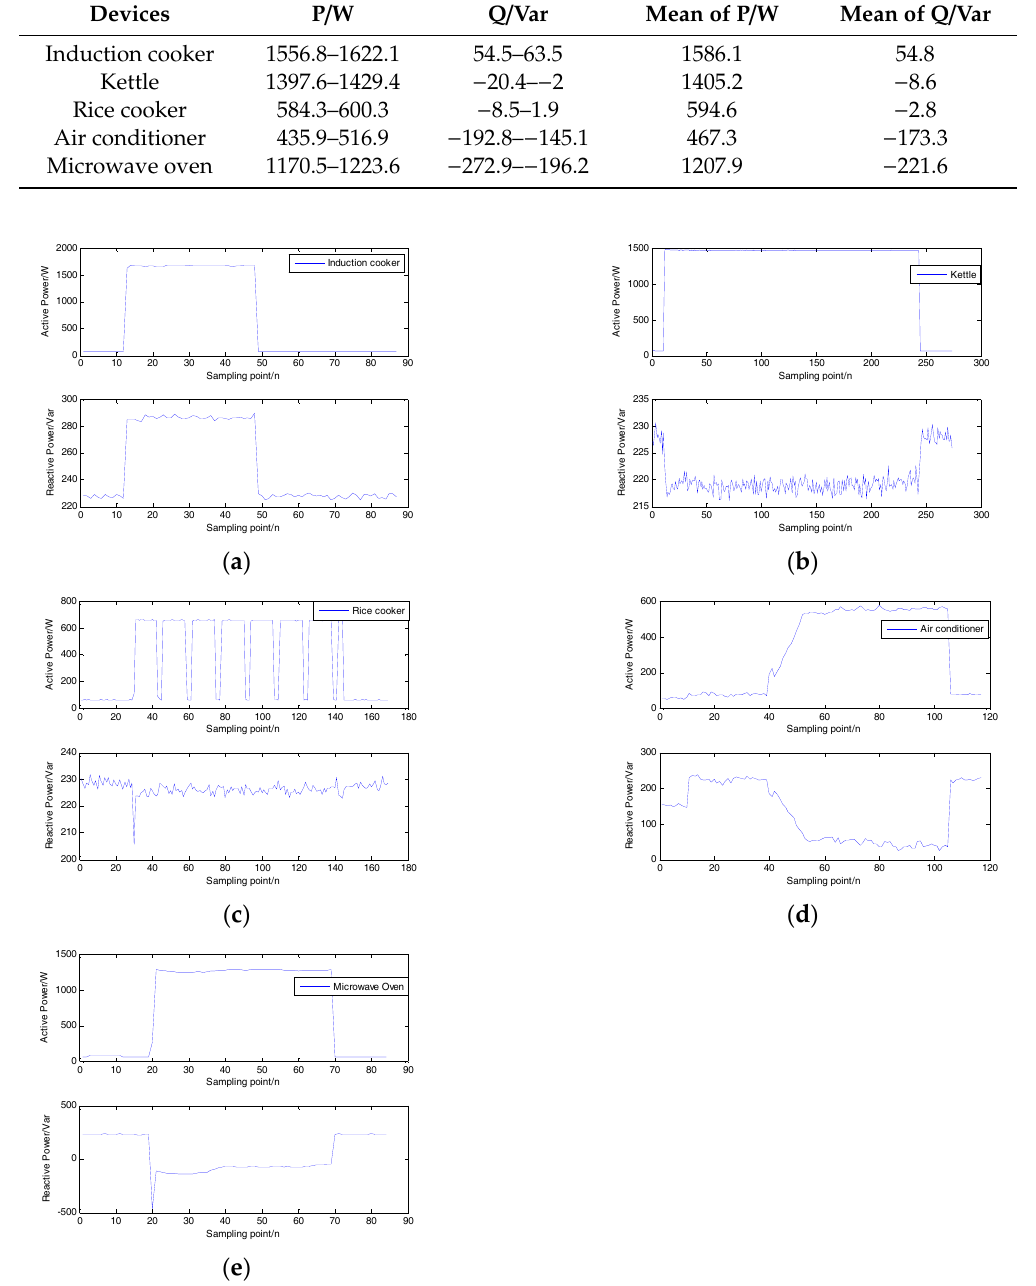
Figure 5. Active and reactive power diagrams of different devices: ( a ) induction cooker, ( b ) kettle, ( c ) rice cooker, ( d ) air conditioner, and ( e ) microwave oven.